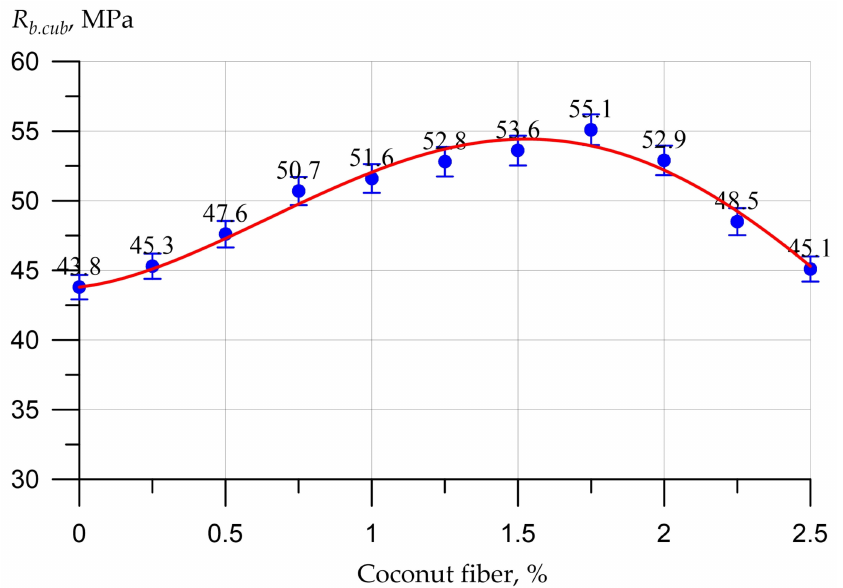
Figure 7. Dependence of the compressive strength ( R b.cub ) of cube concrete samples with a face of 100 mm on the percentage of dispersed reinforcement with coconut fibers.